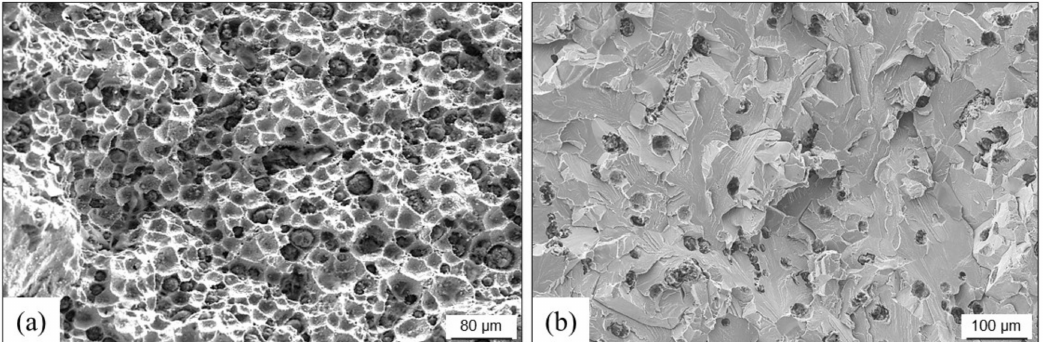
Figure 65. Typical fracture morphologies in ductile cast irons: ductile ( a ) and facetted ( b )